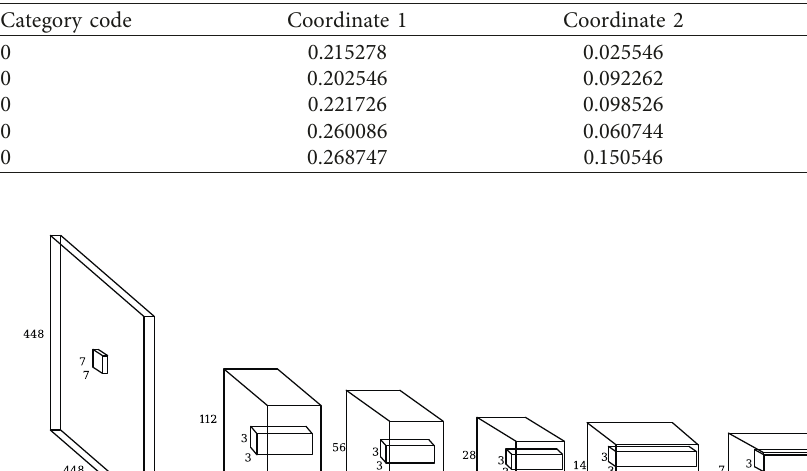
Table 3: Crack marking information